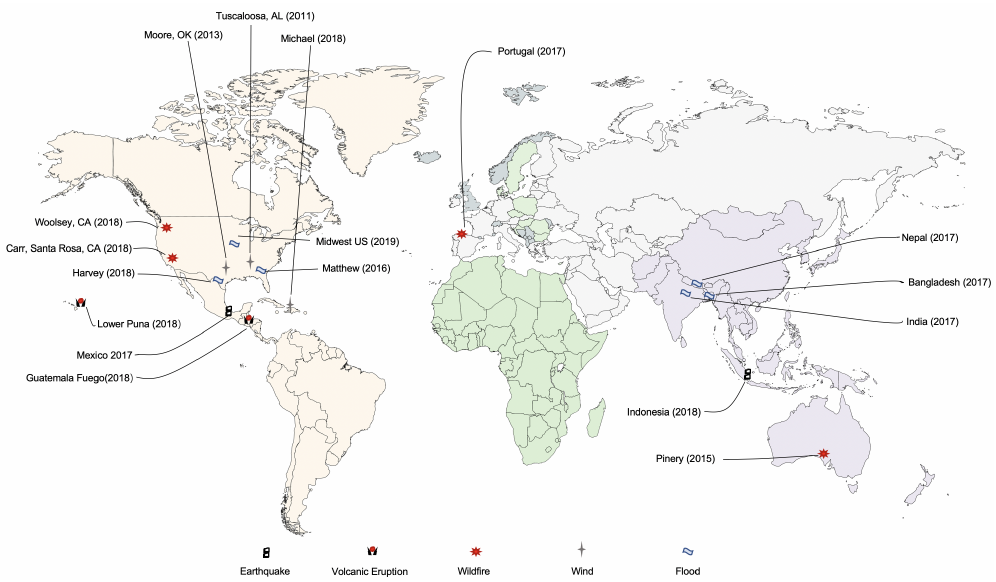
Figure 1. Disaster events included in the xBD dataset.